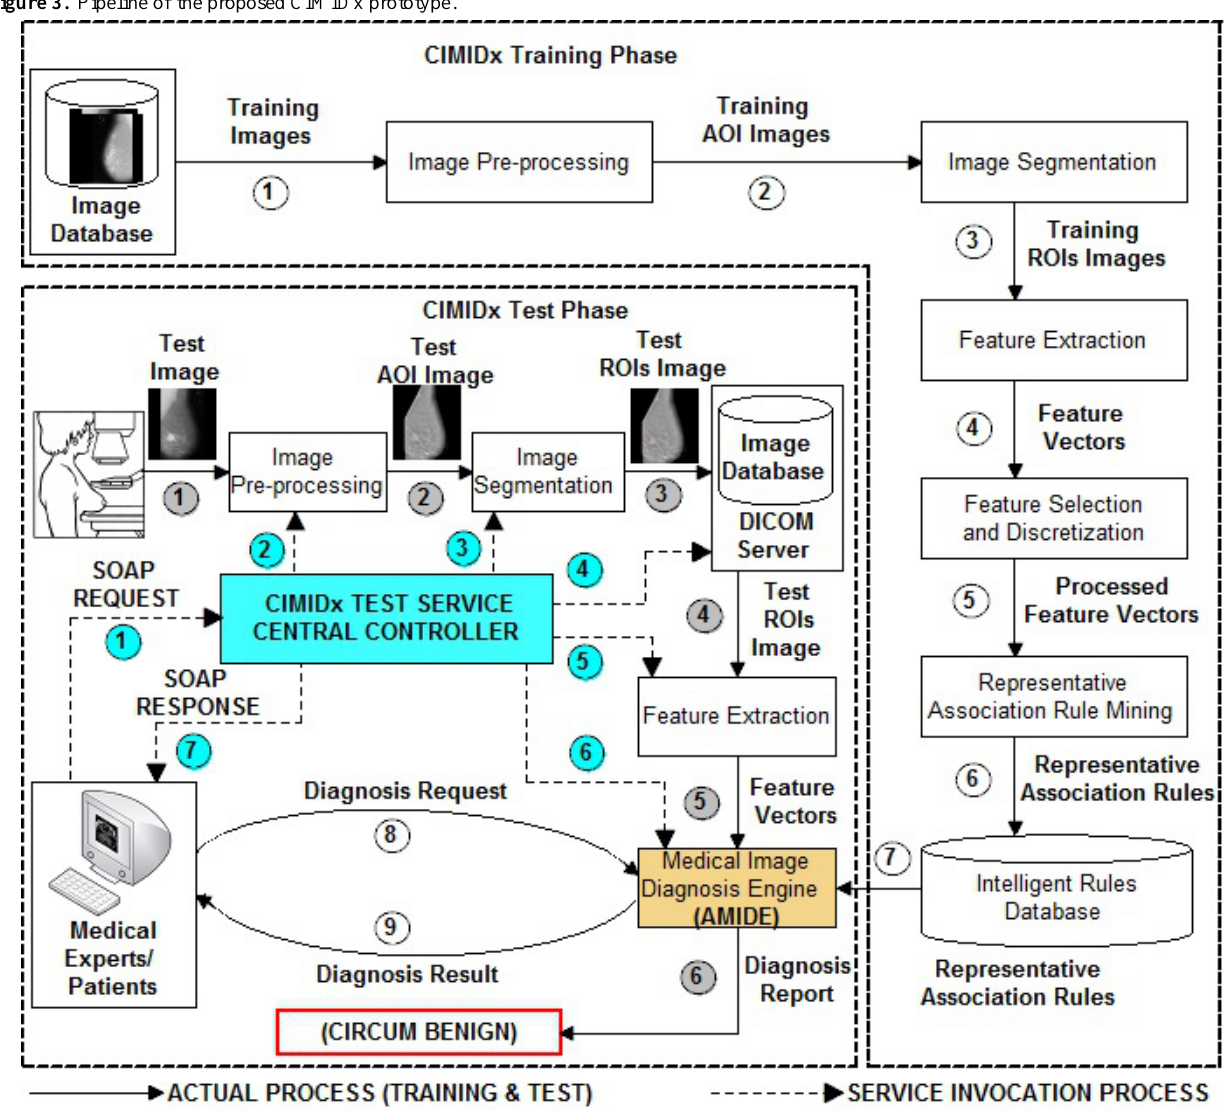
Figure 3. Pipeline of the proposed CIMIDx